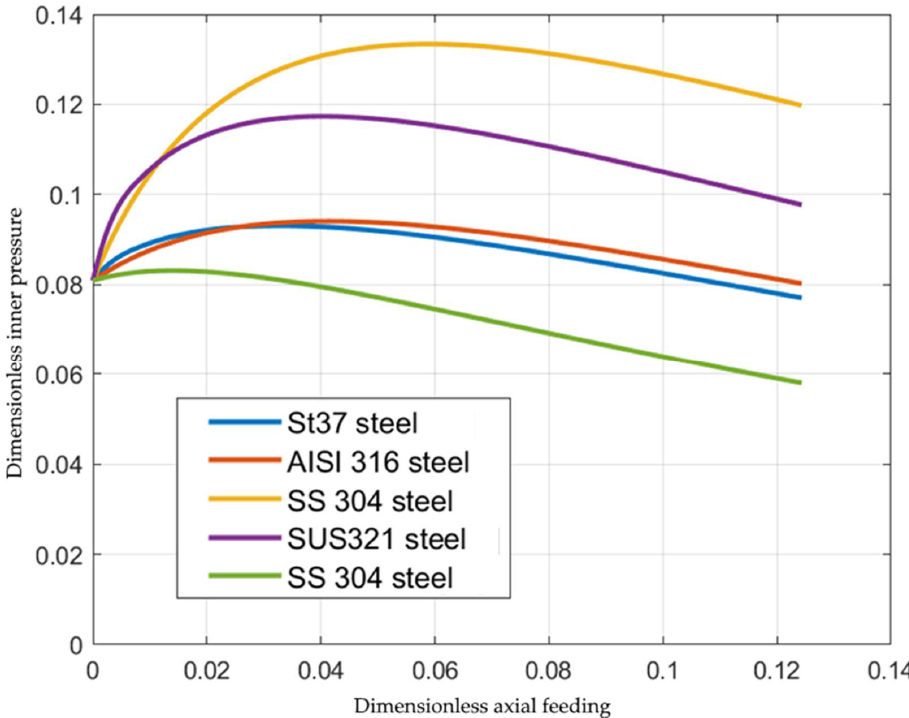
Figure 4. Variation of the inner pressure with the axial feeding for several materials (St37 steel [19], AISI 316 steel [20], SS 304 steel [21], SUS321 steel [22], SS 304 steel [23]).